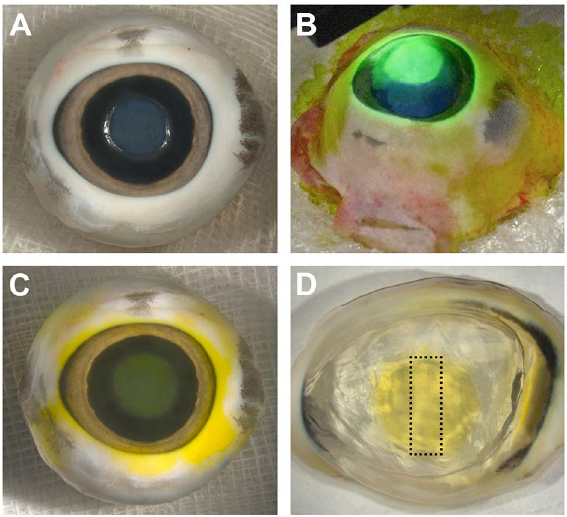
Figure 1. CXL procedure and sample preparation. Enucleated porcine eyes with centrally debrided corneal epithelium. Temporal side on the left, nasal side on the right. Superior aspect facing upwards, inferior aspect downwards. Note the markedly steeper curvature of the corneal margin on the temporal side (left). A ) Prior to administration of riboflavin. Abraded area in the corneal center is clearly visible. B ) UVA irradiation of riboflavin-saturated cornea. Note the pronounced fluorescence of riboflavin. C ) After CXL. Note the marked yellow staining of the cornea within the abraded area due to stromal saturation with riboflavin. D ) Excised corneoscleral ring. Conspicuous yellow staining of the cross-linked area. The dotted rectangle indicates shape and superior-inferior orientation of the dissected tissue specimen used for cryosectioning and AFM analysis.